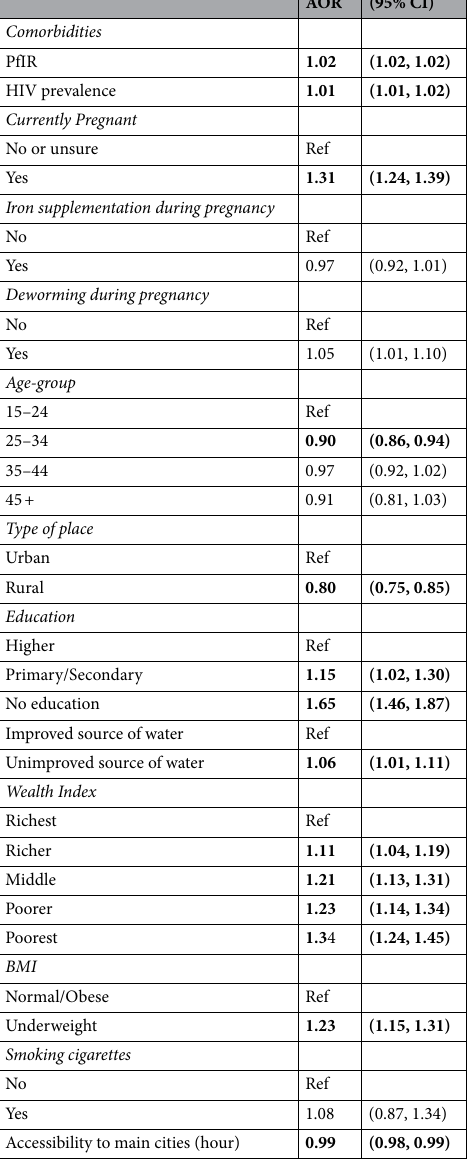
Table 2. Predictors for anemia in women of reproductive age in SSA. Notes: Boldfaced numbers indicate statistical association <0.05. Abbreviations: AOR, adjusted odds ratio; CI, confidence